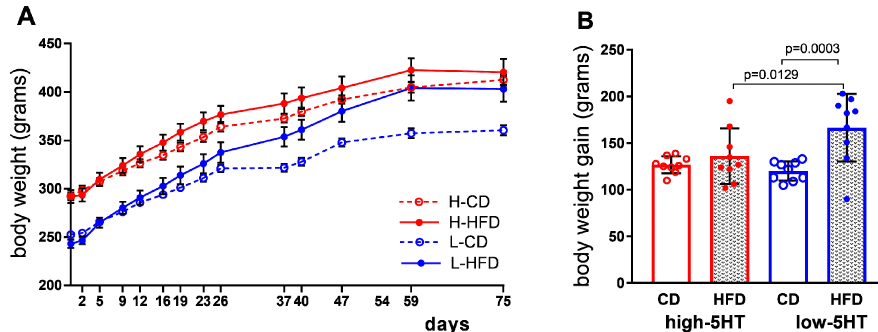
Figure 3. Body weight accumulation ( A ) and total body weight gain ( B ) over 11 weeks of feeding with control diet (CD) or high–fat diet (HFD). Data presented as means ± SEM ( A ) or means ± SD ( B ); N = 9 per group; p -values obtained by LSD post-hoc test after one-way ANOVA are shown. H-CD = animals from high-5HT subline on control diet; L-CD = animals from low-5HT subline on control diet; H-HFD = animals from high-5HT subline on high-fat diet; L-HFD = animals from low-5HT subline on high-fat